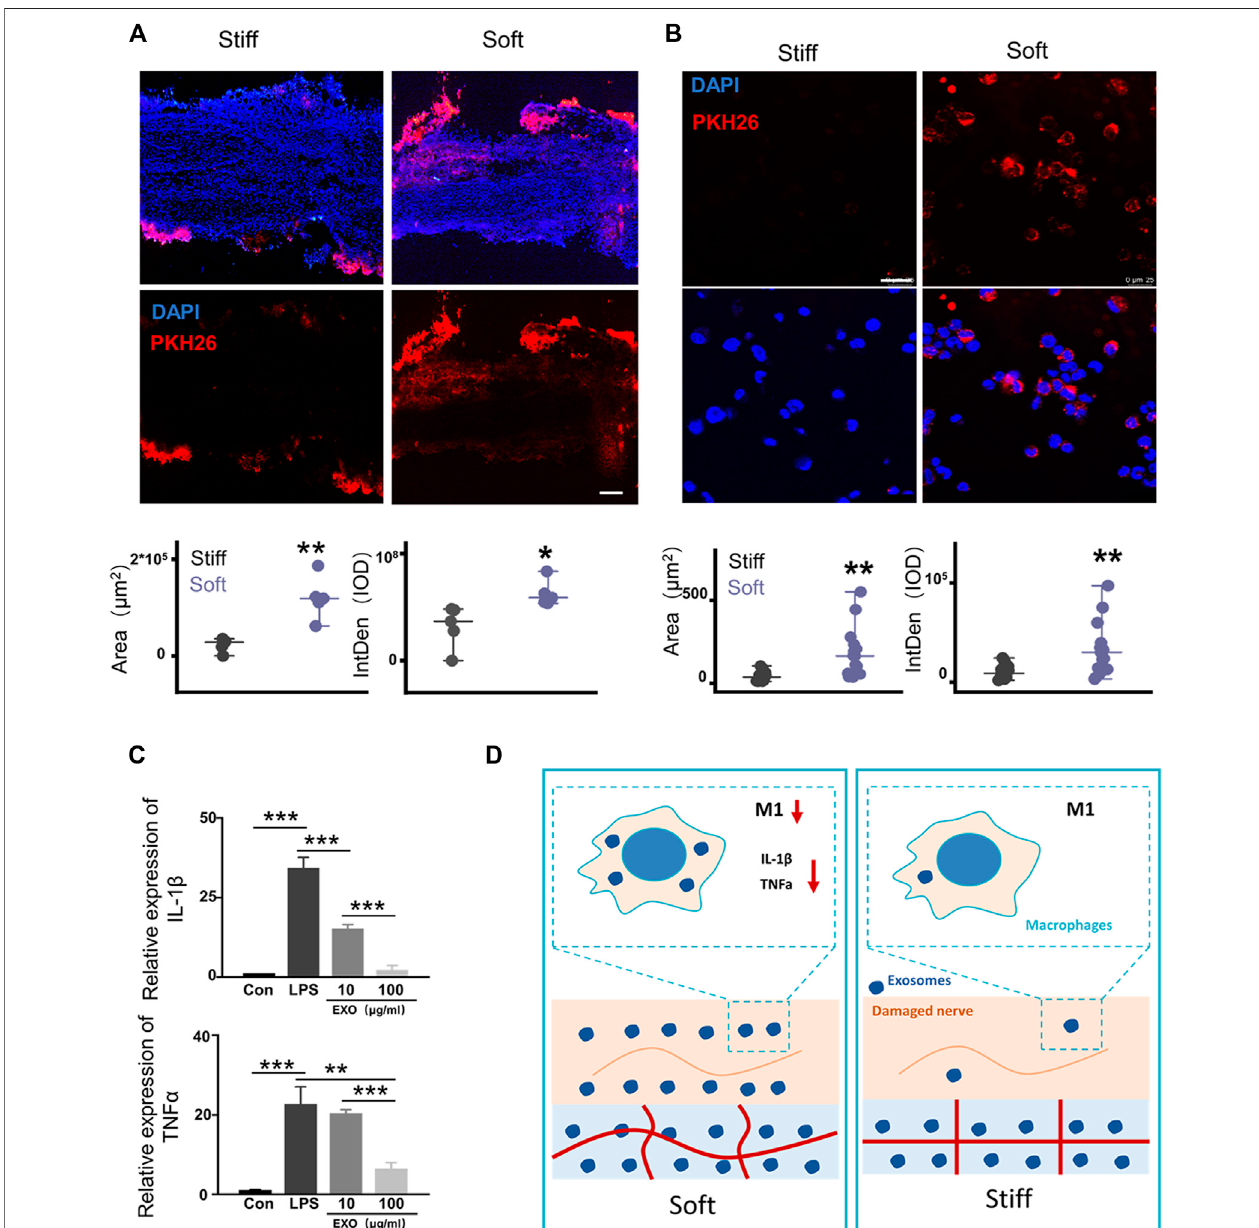
FIGURE4 | Rapid release ofexosomes mediated bysoft hydrogels inhibits macrophage in fl ammation. (A) After 24 h, the hydrogel-embedded sciatic nerves were collected, and the frozen sections were imaged under a fl uorescence microscope. Image analysis showed that compared with the stiff hydrogel – embedded sciatic nerves, the sciatic nerves embedded in the soft hydrogels had a larger fl uorescent area ( p = 0.00162, n = 5) and higher IOD ( p = 0.01827, n = 5; bar = 200 μ m). (B) Hydrogels with different stiffnesses were loaded with PKH26-labeled exosomes and incubated with THP1 cells and PMA (100 ng/ml). After 24 h, the cells were imagedunderalaserconfocalmicroscope(bar=250 μ m).Imageanalysisshowsthatcomparedwiththecellsgrownonstiffhydrogels,thecellsgrownonsofthydrogels had a larger fl uorescent area ( p = 0.00101, n = 15) and higher IOD ( p = 0.00201, n = 15). (C) After PMA (100 ng/ml) induced THP1 to adhere to the wall (con), LPS (100 ng/ml) was used to induce the cells to differentiate into M1 for 12 h (LPS). Then, the cells were treated with different concentrations of exosomes to detect the expressionoftherelatedgenes,IL-1 β andTNF- α (IL-1 β :convs.LPS p =6.57496E-5,LPSvs.10 μ g/ml p =7.66959E-4,10 μ g/mlvs.100 μ g/ml p =3.2624E-4;TNF- α : con vs. LPS p = 9.737936E-4, LPS vs. 10 μ g/ml p = 0.00355, 10 μ g/ml vs. 100 μ g/ml p = 1.63632E-4; n = 3). (D) Schematic diagram of the mechanism by which exosome release affects damaged nerve repair. The rapid release of exosomes from the soft hydrogel can reduce macrophages and the expression of proin fl ammatory IL-1 β and TNF- α in M1 macrophages, thereby promoting the repair of the injured nerve. * p < 0.05; ** p < 0.01; and *** p < 0.001, t test.